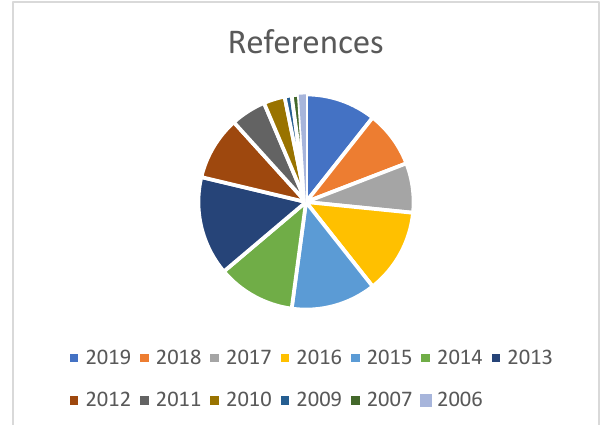
Figure (1). For different years the fractions of references included out of total